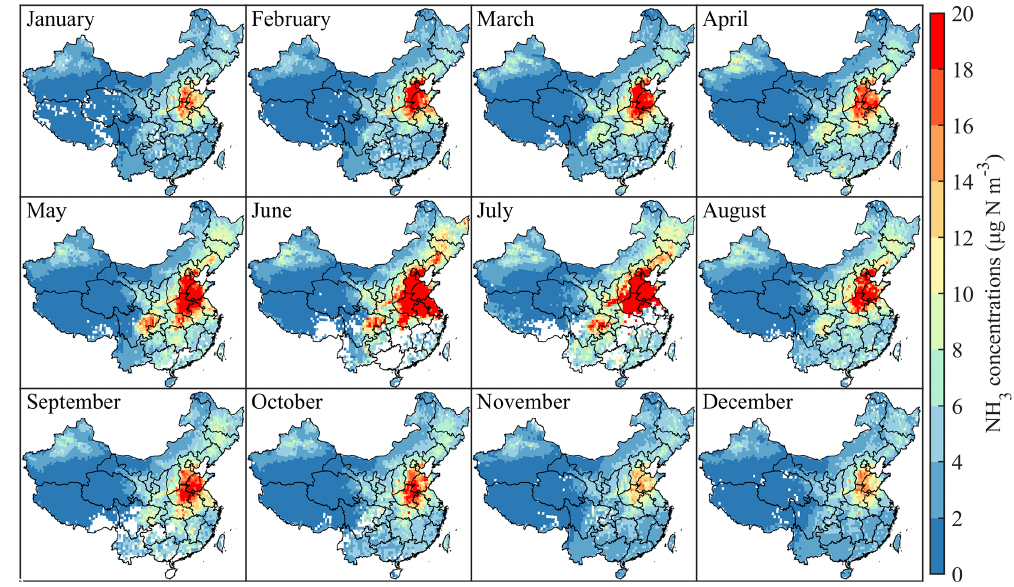
Figure 3. Spatial distribution of monthly surface NH 3 concentrations in China by GIIRS in 2019–2020.